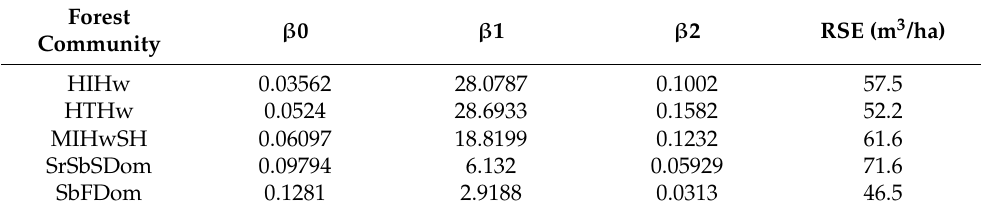
the PSP method estimations had an RMSE between 14.1 and 23.3 t/ha for the same forest communities. The lowest RMSE was usually found in the Fine Root pool, where CBM estimates were on average between 0.7 and 0.8 t/ha different than the observed data and PSP estimations were between 0.5 and 0.8 t/ha different. In all cases, the PSP method had a lower or equal RMSE (and therefore, higher or equal congruence to observed data) than the CBM method, with methods having an equal RMSE in the HTHw (Foliage pool), SbFDom (Fine Root pool), and SrSbSDom (Other + Bark and CWD pools) forest